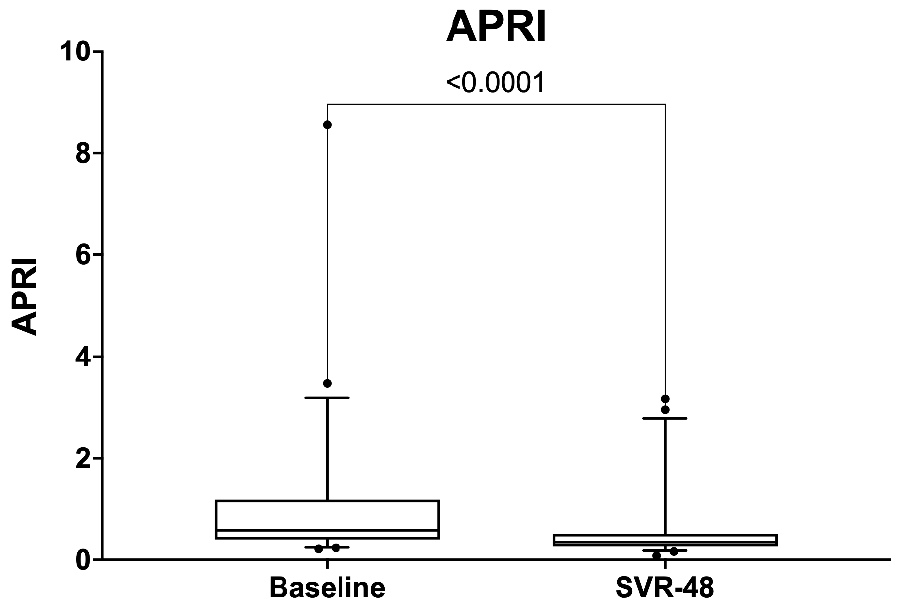
Figure 5. Comparison between APRI score at baseline and SVR48.